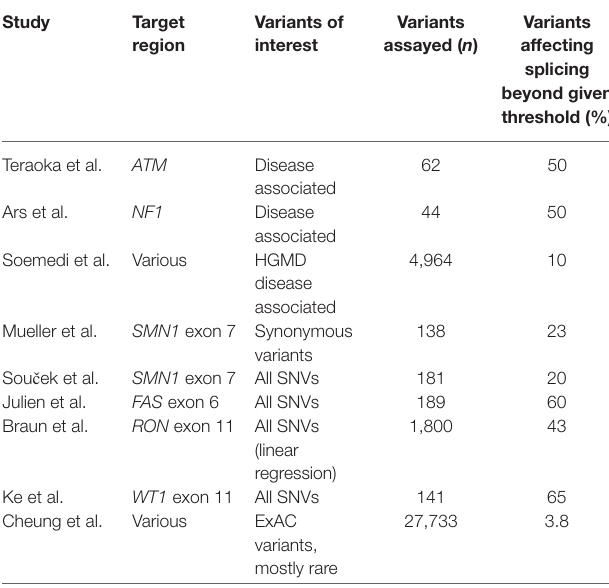
TABLE 1 | Proportion of single nucleotide variants (SNVs) that disrupt splicing across studies.